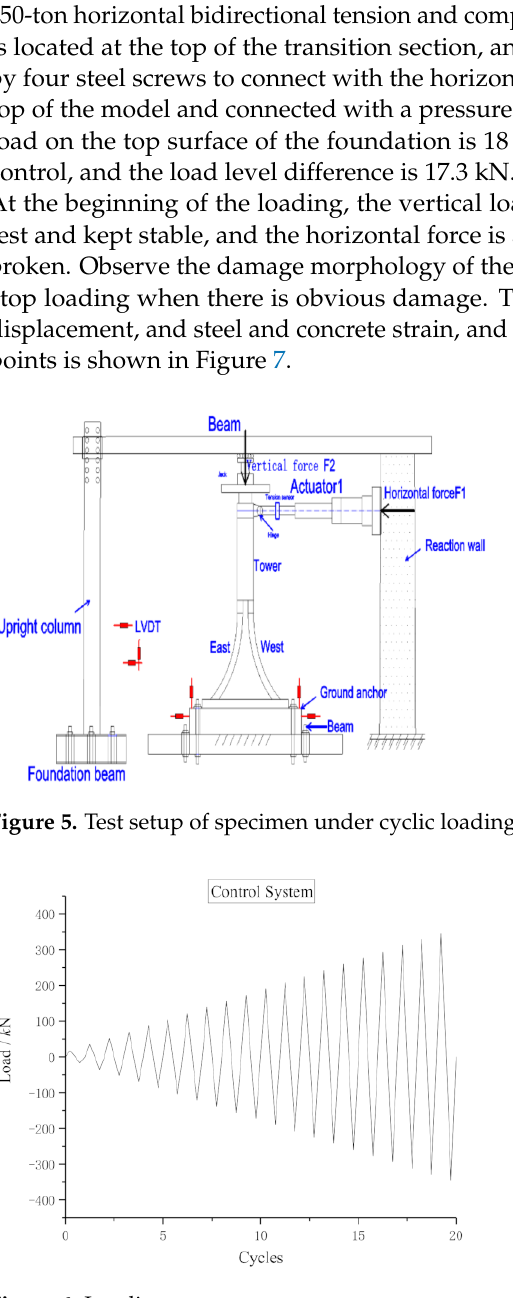
Figure 6. Loading